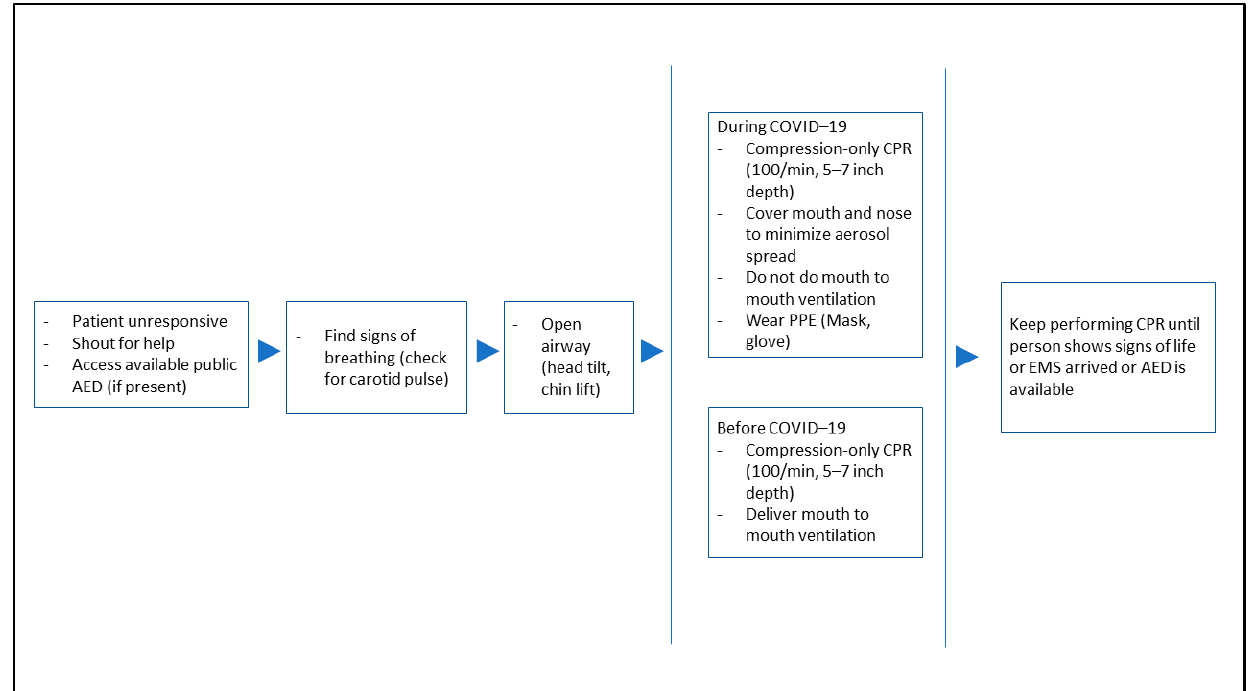
Figure 1. The differences between cardiopulmonary resuscitation (adult) standard operating proce- dures before and during the COVID-19 pandemic.